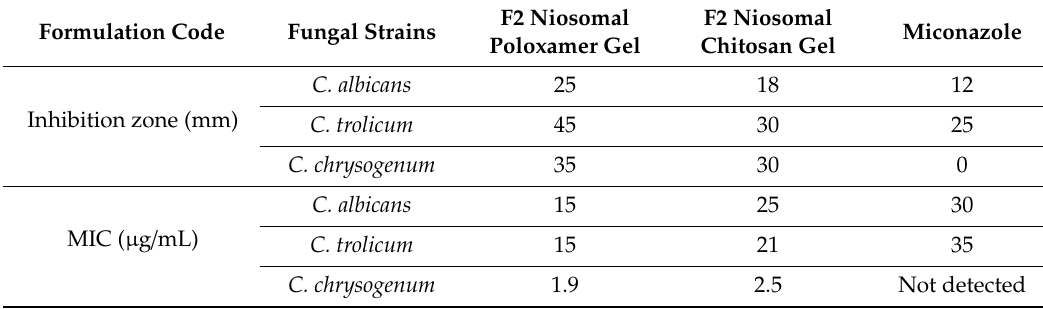
Table 12. The antifungal activity of di ff erent fluconazole niosomal gel